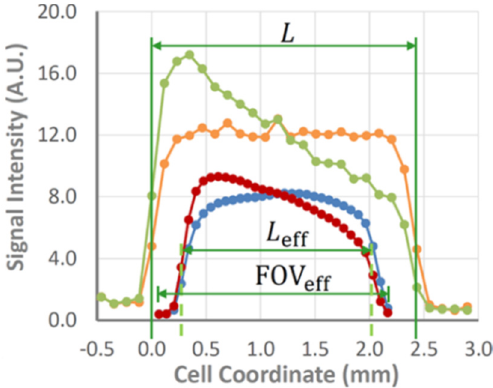
Figure 4. Comparison of the baseline and steady-state signal intensity profiles of 1.00 M LiPF 6 in EC/PC/DMC, 5:2:3 (v/v) measured by chemical shift imaging (CSI) (blue and red lines; PC is propylene carbonate) and double-half k-space (DHK) single-point ramped imaging with T 1 enhancement (SPRITE) (orange and green lines) at 10 °C with a nominal cell length of 2.43 mm, charging the graphite electrode at 7.2 A m − 2 . Horizontal compression and translation of the field of view has been applied to the CS images, illustrating the dead space captured by DHK SPRITE, but missed by CSI. (Note that the DHK SPRITE images have been vertically scaled to facilitate simultaneous plotting with the CS images). (Reproduced with permission from [39]; Copyright 2017 American Chemical Society).